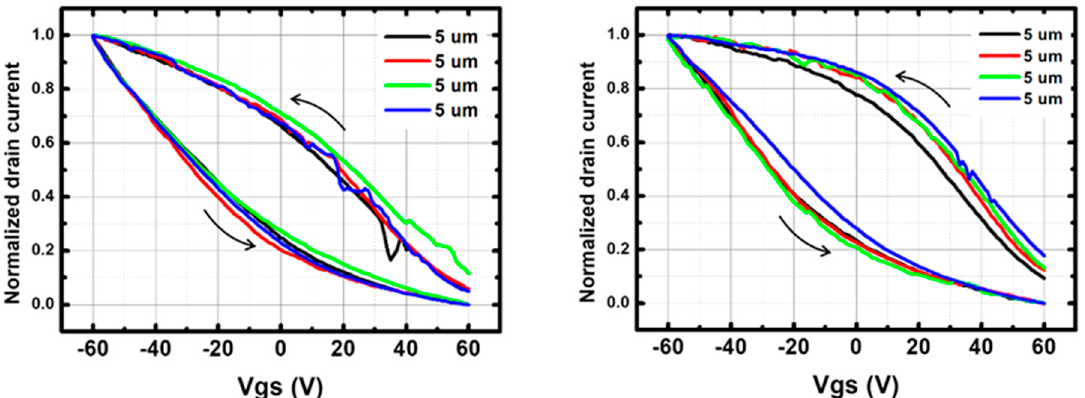
Figure 5. Normalized I–V transfer curves (current level divided by I on ) of 5 µm channel ( left ) p-CNTFETs and ( right ) f-CNTFETs at drain–source voltage (V ds ) of +5 V in air. Four different 5 µm transistors are shown for each type of FETs. The arrows indicate gate–source voltage (V gs ) sweeping direction.